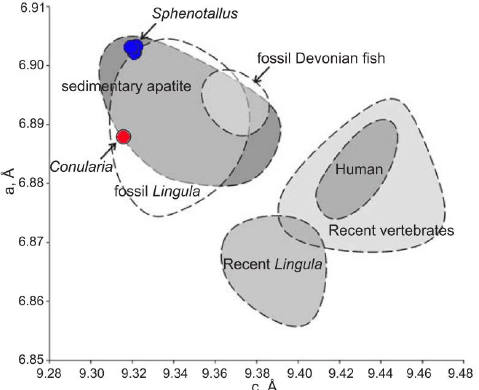
Figure 14. Lattice parameters of Sphenothallus apatite compared with Conularia and other biological and sedimentary apatites [14]. The length of unit cell edges: a and c. Data about other organisms and sedimentary apatites from Nemliher [38].